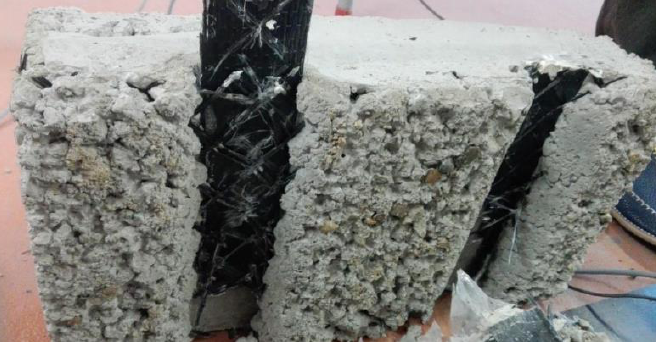
Figure 5. Failure mode of A-IM cases combining mesh debonding from the CFRP sheet and mesh breakage.